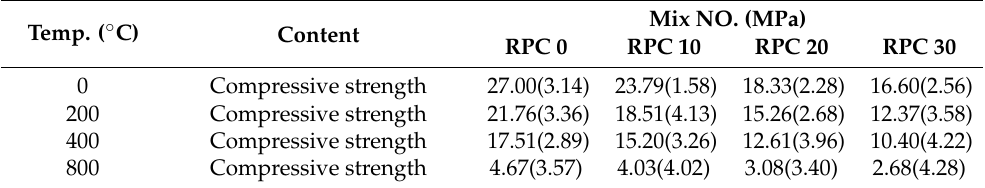
Table 4. Compressive strength of rubber-concrete for high temperatures.